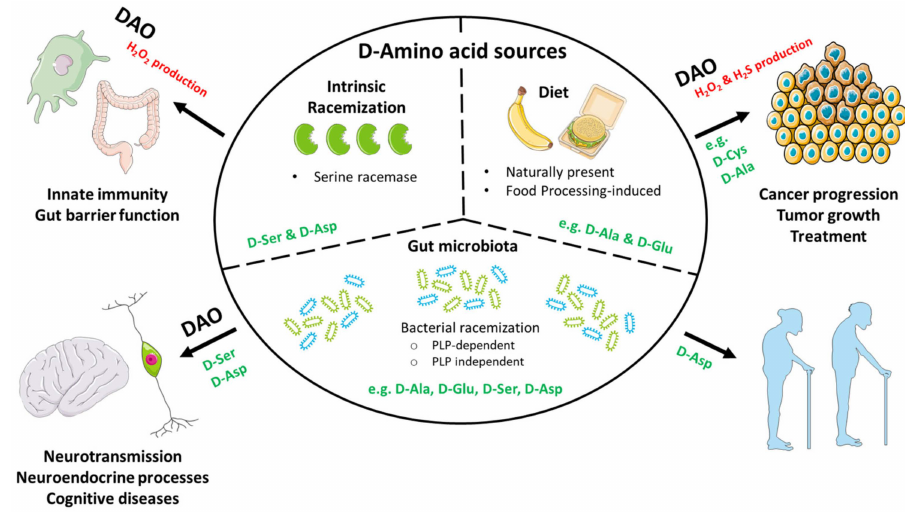
Figure 2. Schematic overview of d -amino acid sources and ( d -amino acid oxidase (DAO)-dependent) links to physiology and disease as discussed in the present